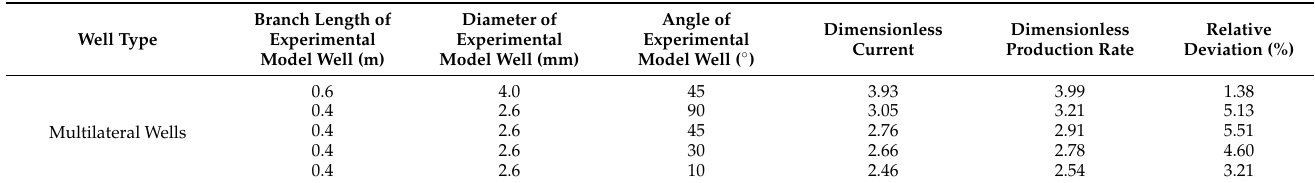
Table 4. Comparison of results between experimental model and semi-analytical model for multilat- eral wells.